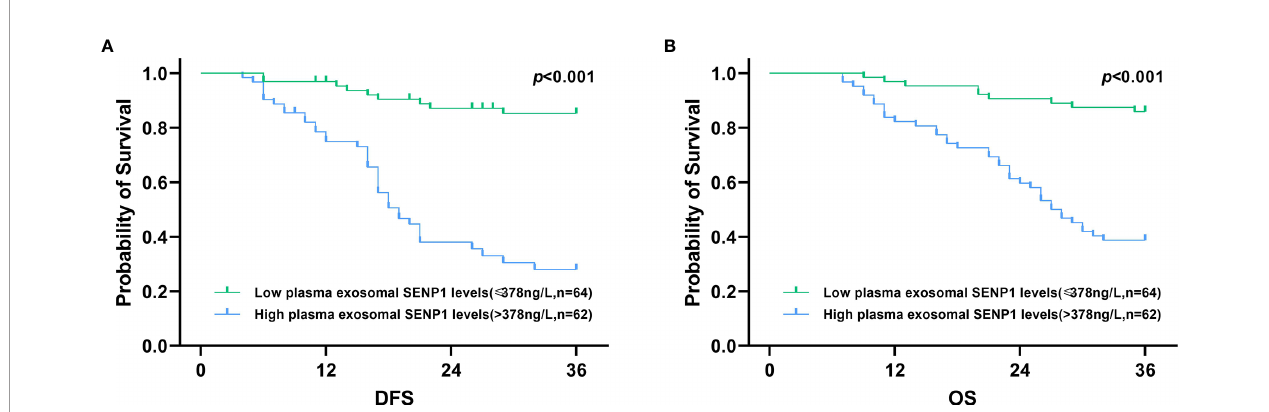
FIGURE 3 | Association of plasma exosome-derived SENP1 levels with DFS and OS in melanoma patients. (A) Among all melanoma patients, DFS was worse in melanoma patients who had higher plasma exosome-derived SENP1 levels than those melanoma patients with lower plasma exosome-derived SENP1 levels ( P < 0.001).